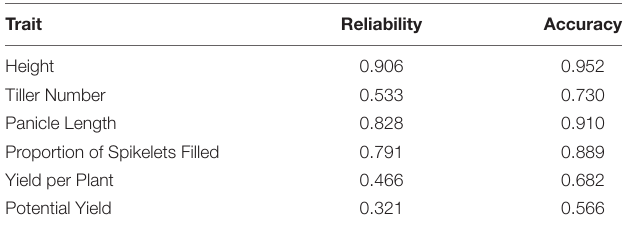
TABLE 5 | Reliabilities and accuracies of phenotypic selection for hybrid performance.